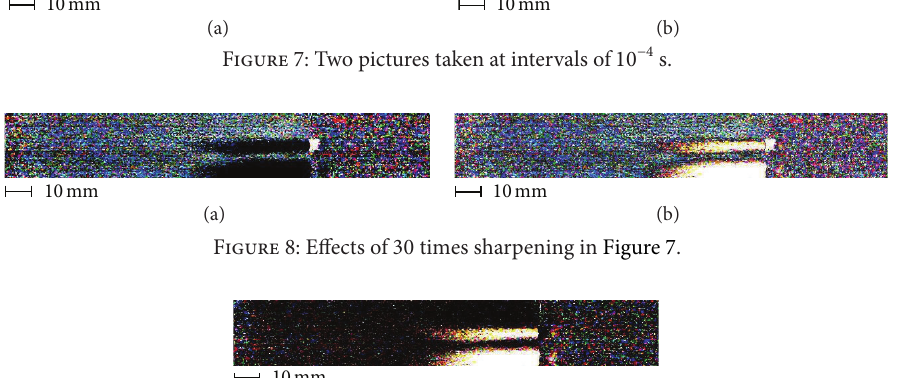
Figure 8: Effects of 30 times sharpening in Figure 7.